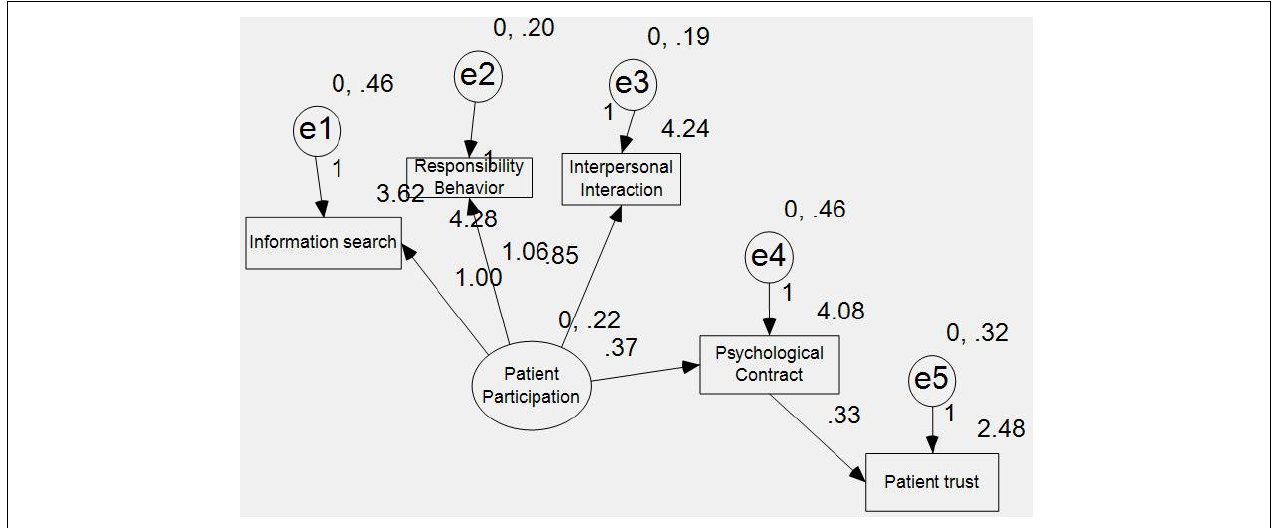
FIGURE 2 | Standardized path figure between patient participation, patient’s psychological contract and patient trust.